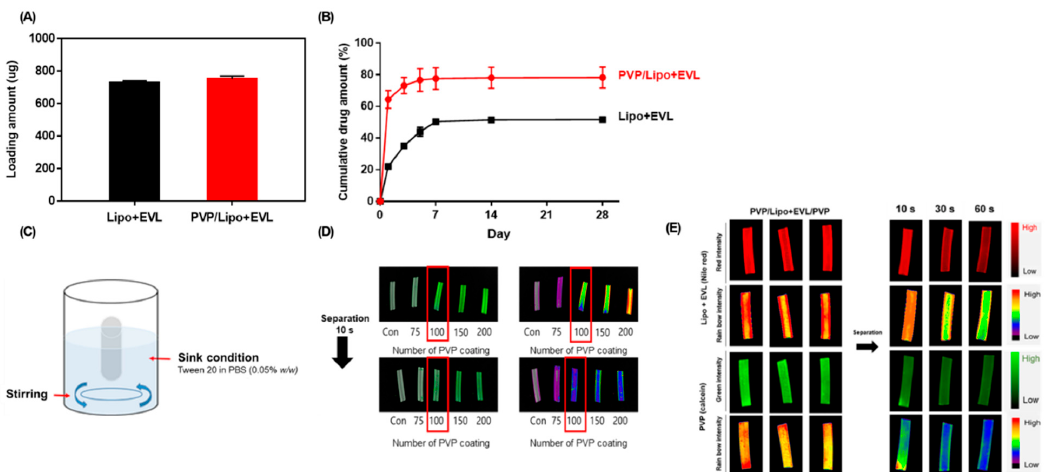
Figure 5. Functionalities of PVP and Lipo+EVL-coated layers. ( A ) Loading amount of drug onto Nylon tube depending on 1st layer with PVP. ( B ) Comparative study on drug release of Lipo + EVL-coated Nylon tube (black) and PVP/Lipo + EVL-coated Nylon tube (red). ( C ) The set-up for in vitro experiments to mimic blood flow in the blood vessel. ( D ) Optimization of coating condition for PVP and separation of the 1st PVP layer for 10 s. ( E ) The fluorescence images for time-dependent separation of coated layer for 10, 30, and 60 s in sink condition. Red: Nile red-labeled liposome, Green:5(6)- carboxyfluorescein-labeled PVP. Values are presented as mean ± SD ( n = 3).